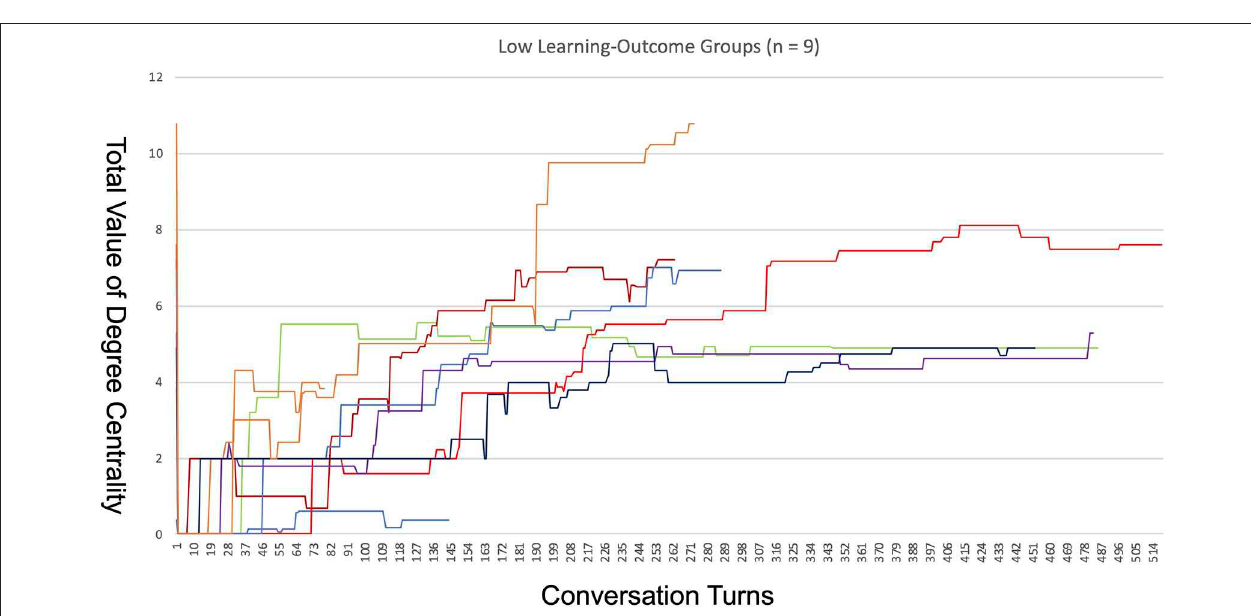
FIGURE 3 | Temporal change in the total value of degree centrality of the vocabulary network in low conceptual understanding